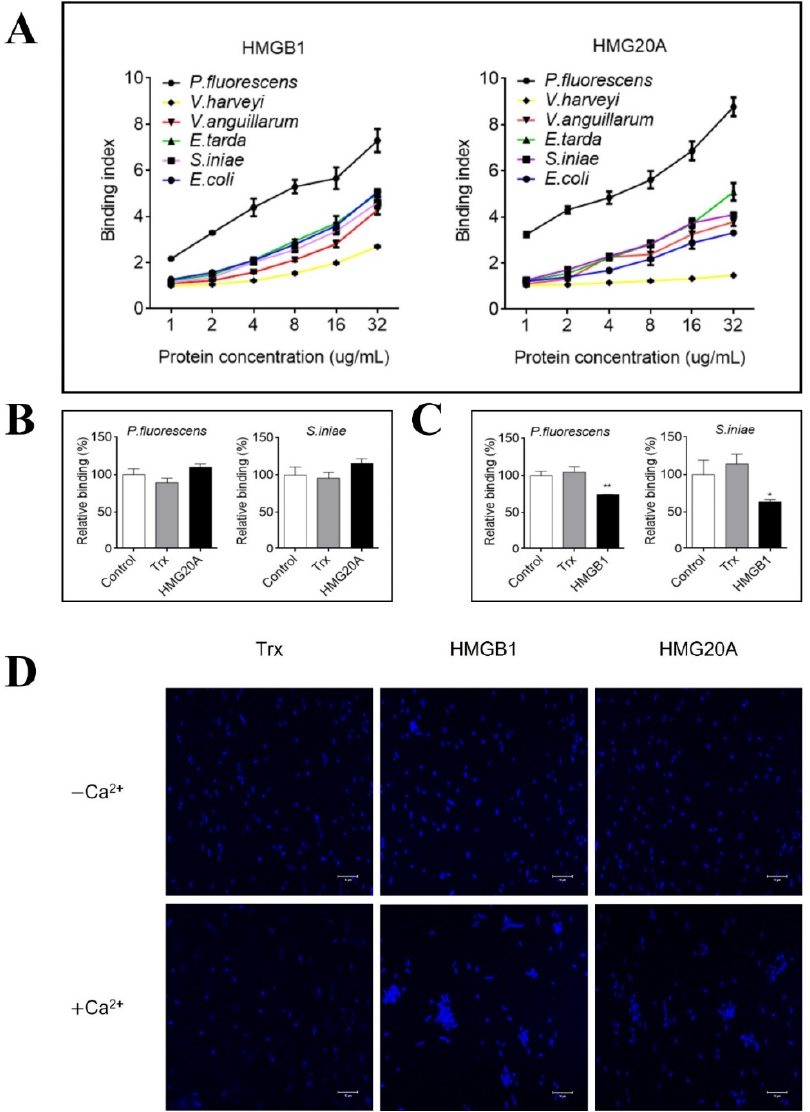
Figure 4. Interaction of HMGB1 and HMG20A with bacteria. ( A ) HMGB1 and HMG20A were incubated with Pseudomonas fluorescens , Vibrio harveyi , Vibrio anguillarum , Streptococcus iniae , Edwardsiella tarda , or Escherichia coli at different concentrations for 2 h. The binding of HMGB1 and HMG20A to bacteria was determined by ELISA. ( B ) P. fluorescens and S. iniae were pre-incubated with PBS (control), Trx, or HMG20A and then incubated with HMGB1. Bacteria-bound HMGB1 protein was determined as above. ( C ) P. fluorescens and S. iniae were pre-incubated with PBS (control), Trx, or HMGB1 and then incubated with HMG20A. Bacteria-bound HMG20A protein was determined as above. For panels ( B , C ), values of triplicate experiments are shown as means ± SD. ** p < 0.01; * p < 0.05. ( D ) P. fluorescens was incubated with HMGB1, HMG20A, or Trx for 2 h in the presence or absence of calcium. DAPI staining was performed to indicate bacterial cells. The bacterial-binding proteins were observed with a confocal microscope. Bar size, 10 µ